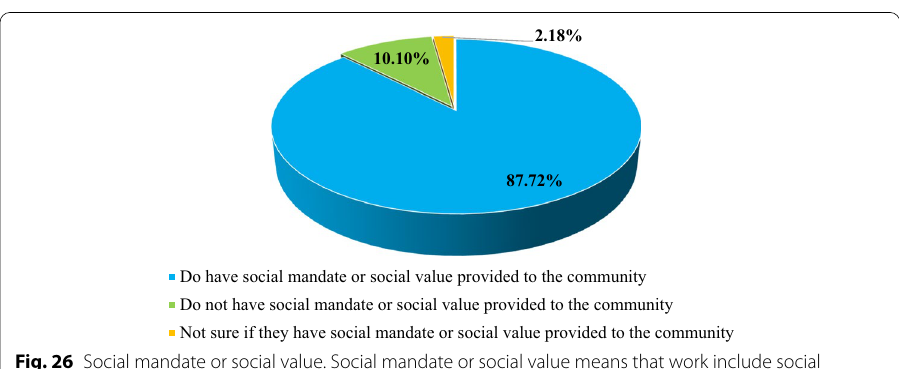
Fig. 26 Social mandate or social value. Social mandate or social value means that work include social integration that may be at any point of work. Like unprivileged women are the main suppliers for your product /service, products are environment-friendly, activities respond to the SDG’s & spread awareness about a global issue and selling the final product/service at lower prices for people with less purchasing